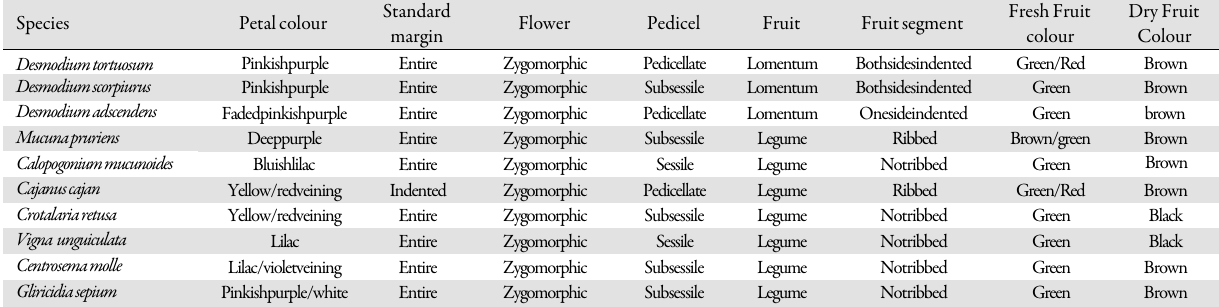
Table 1. Summary of the qualitative morphological traits of the studied species of the subfamily Papilionoideae (Contd)